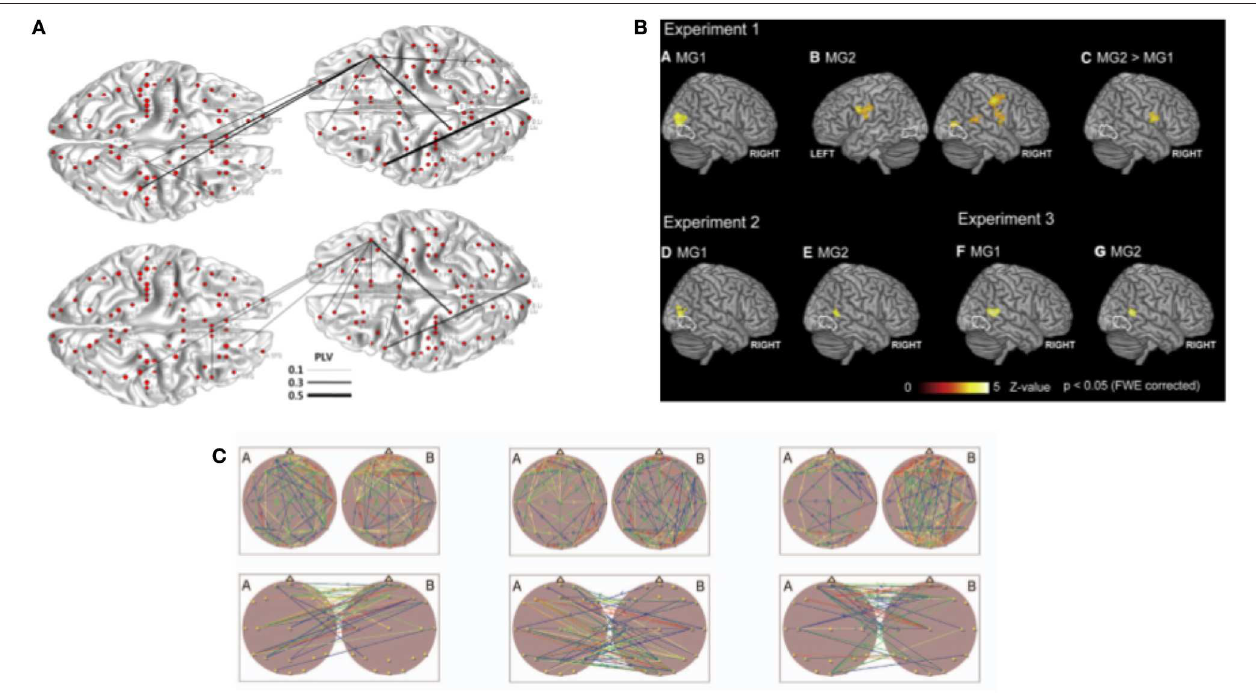
FIGURE 2 | Analysis methods used in hyperscanning to investigate between brain relationships. (A) From Yun et al. (2012). Phase synchrony was used as a coupling measure to investigate between-brain connections in implicit coordination task. Topography of the phase synchrony (PLV) between different regions of interest of two participants are presented for theta (4–7.5 Hz) and beta (12–30 Hz) oscillations. (B) From Koike et al. (2016). Between-brain synchronization estimated with correlation. (C) From Müller et al. (2013). Brain topography maps illustrating significant connection within and between the brains. Example of graph theory measures applied to analyze synchronization during musical improvisation on the guitar. All parts reproduced/adapted under CC